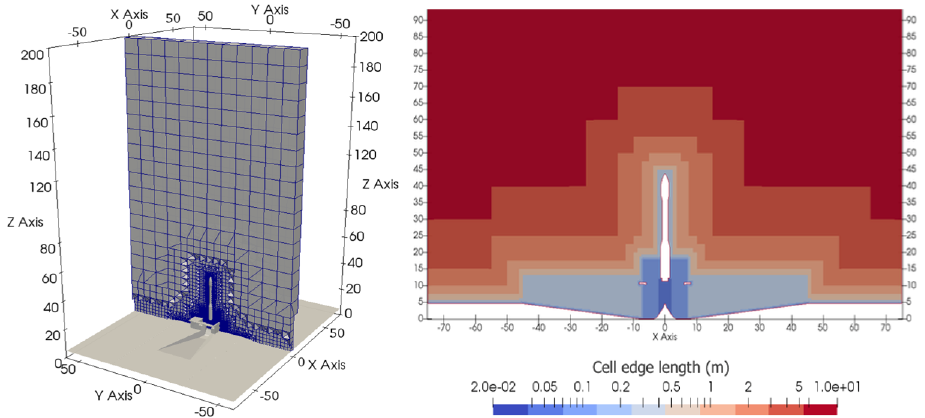
Figure 2. Mesh details. On the left picture, mesh domain cross-section representing each of the cells. On the right, representation of the mesh classified by the size of the